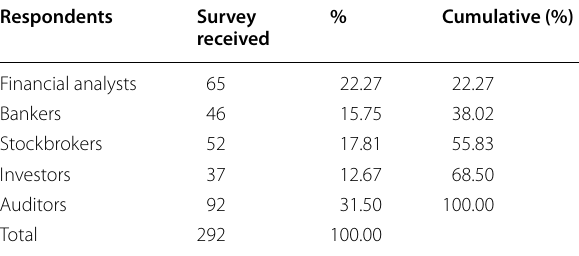
Table 2 Respondents occupation. Source: Survey